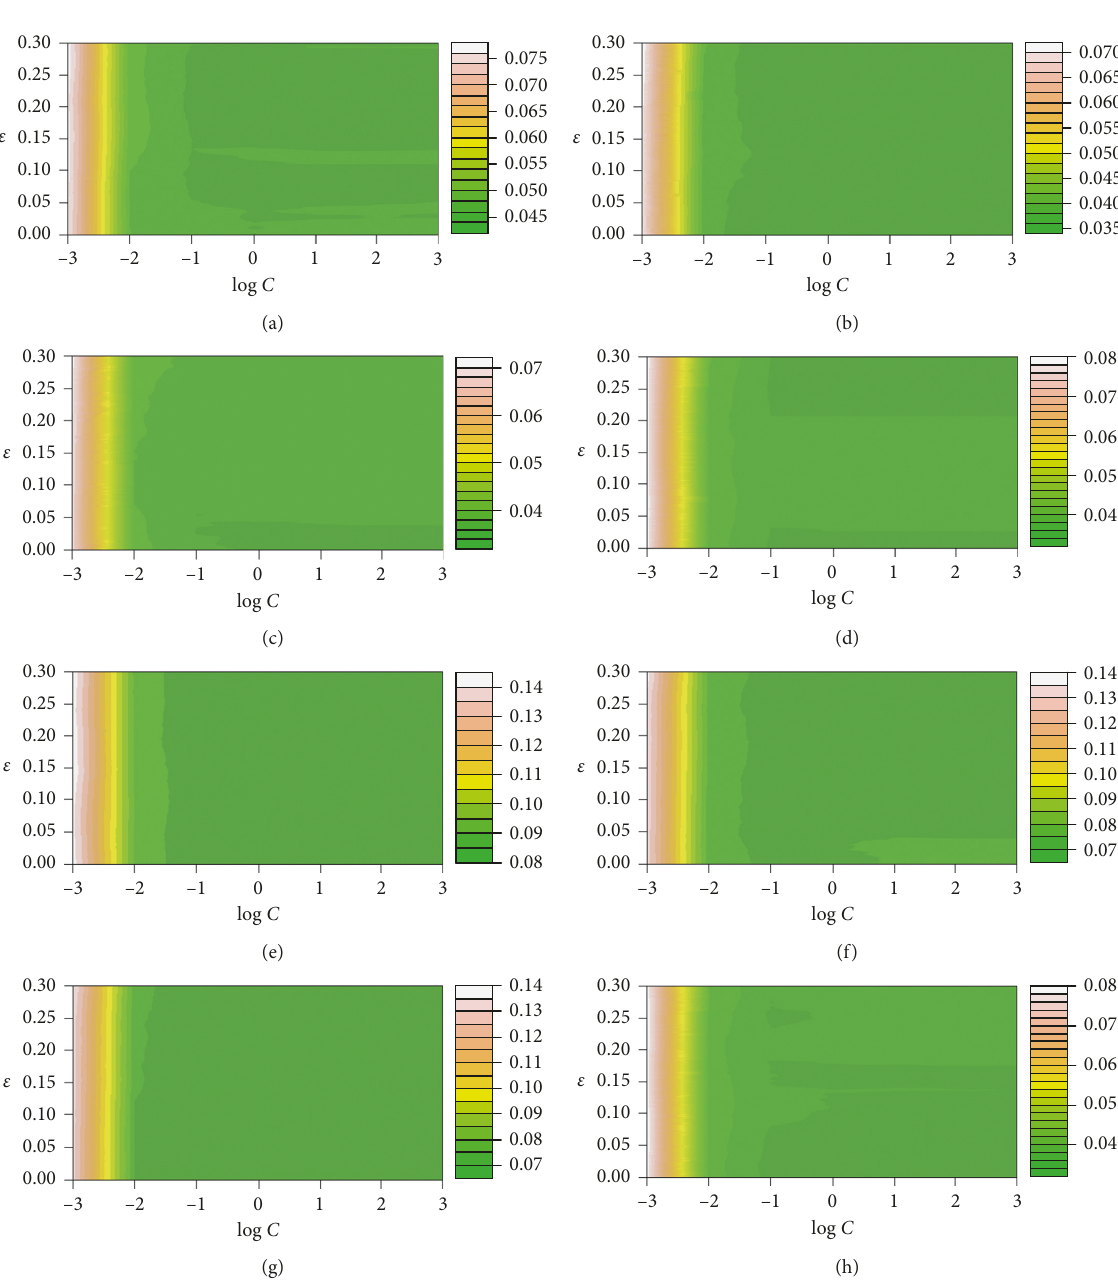
Figure 3: Sensitivity of SVR hyperparameter calibration to incremental soil predictor variables: (a) FC1, (b) FC2, (c) FC3, (d) FC4, (e) WP1, (f) WP2, (g) WP3, and (h)